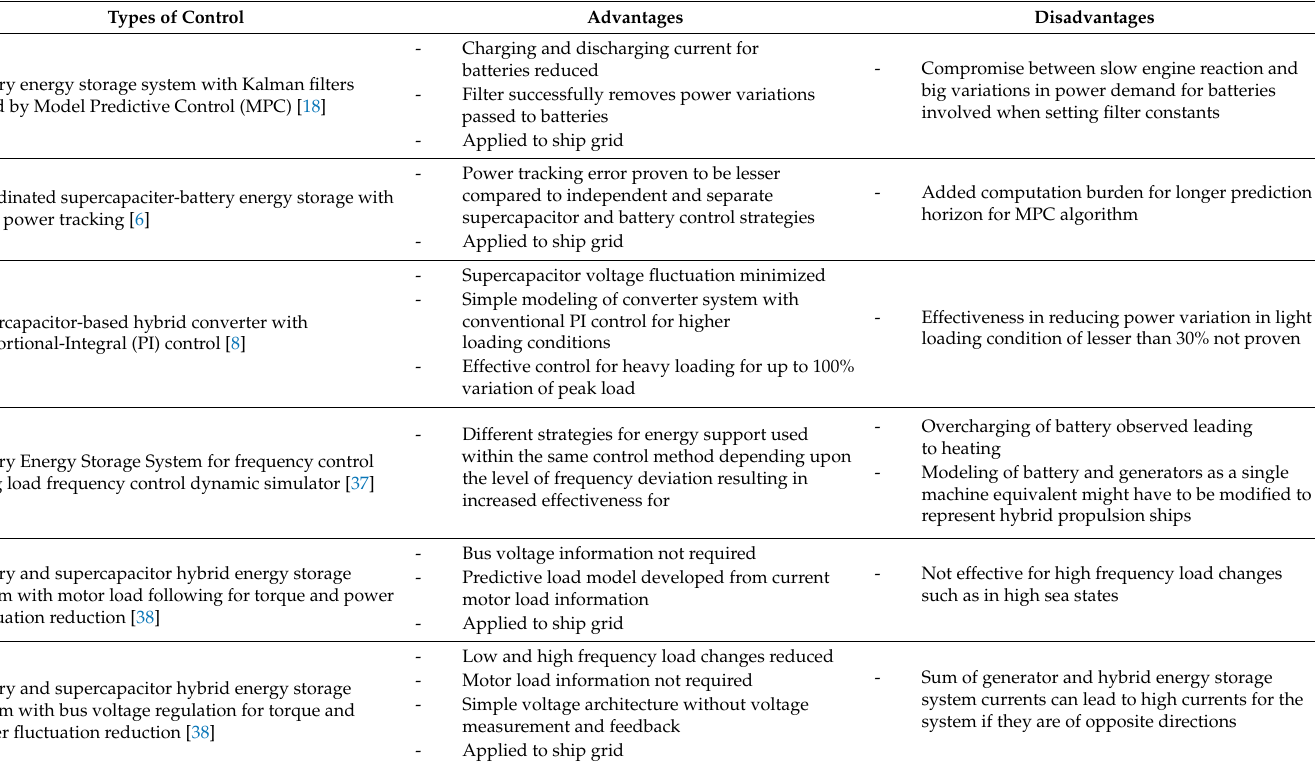
Table 5. Summary of advantages and disadvantages of energy storage control